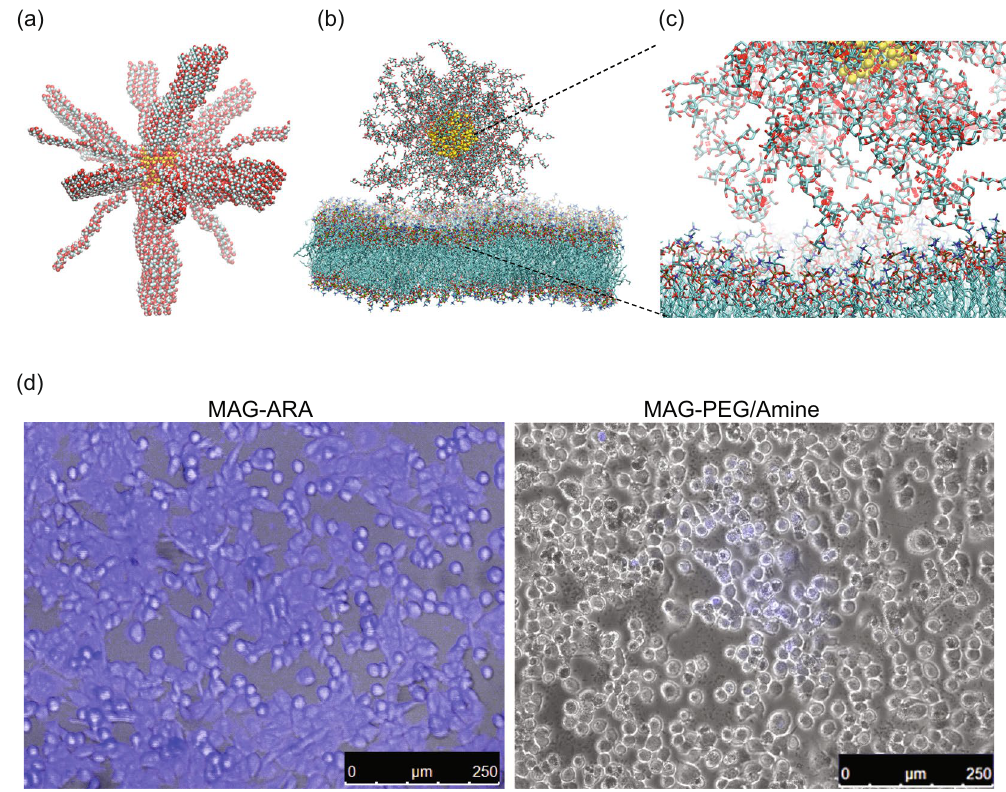
Figure 1. Membrane interaction and internalization of MAG-ARA. ( a ) Initial configuration of the MAR-ARA NP in vacuum. Fe is shown in yellow, oxygen in red, carbon in cyan in van der Waals representation. ( b ) Final configuration of the MAR-ARA NP in contact with a DPPC bilayer. Fe is shown in yellow, oxygen in red, carbon in cyan in van der Waals representation. ( c ) Example of L-arabinose and D-galactose hydrogen bonds as they interact with the phosphate group of DPPC. Hydrogen atoms have been omitted for clarity. Oxygen is shown in red, carbon in cyan in licorice representation. ( d ) Superposition of a confocal fluorescence image (blue) and a bright filed image from MDA-MB-231 breast cancer cells incubated with MAG-ARA and control (MAG-PEG/ Amine)